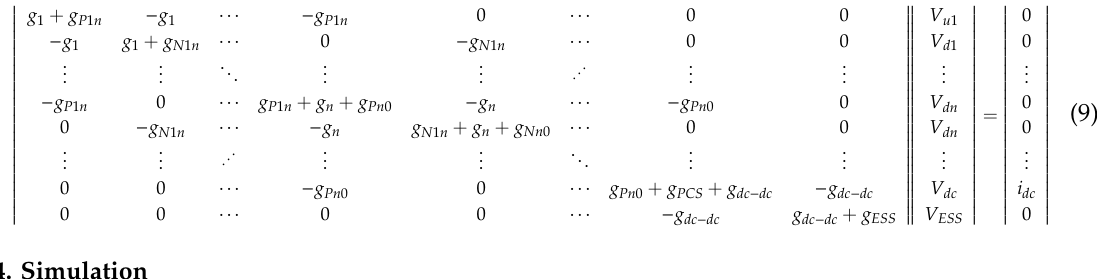
Figure 4. Modified control diagram of iterative method.